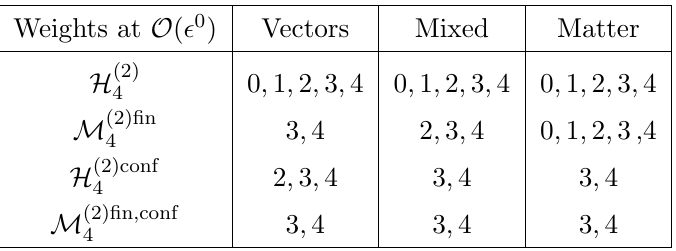
Table 2 . The transcendental weights appearing for various encodings of the (cid:12)nite part of the two-loop amplitudes under consideration. The (cid:12)rst row shows the weights for the hard part of the various unrenormalized two-loop amplitudes as de(cid:12)ned by minimal subtraction (2.22b); the second row shows the weights appearing after IR subtraction as de(cid:12)ned by eq. (5.3). The third and fourth rows show the weights of the same terms evaluated at the conformal point N f = C A =T F